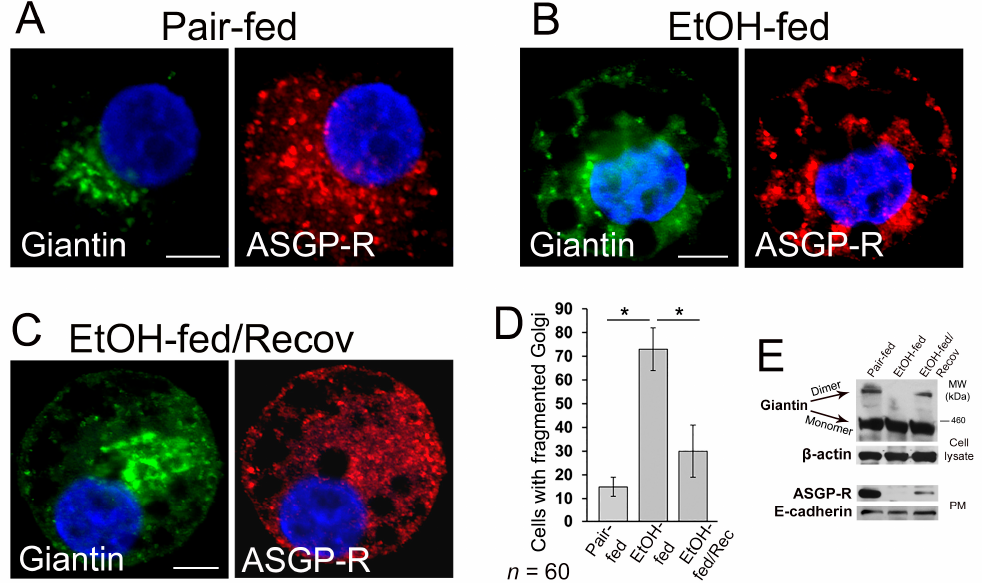
Figure 2. Post-alcohol Golgi biogenesis in vivo. ( A – C ) Giantin and asialoglycoprotein receptor (ASGP-R) immunostaining in hepatocytes obtained from rats: pair-fed ( A ), ethanol (EtOH)-fed ( B ), and EtOH-fed followed by the recovery; bars, 5 µ m ( C ); ( D ) Quantification of cells with fragmented Golgi in cells from ( A – C ); n = 60 cells from two independent experiments, results are expressed as a mean ± SD; * p < 0.001; ( E ) Top panel: giantin W-B of lysates from cells described in ( A – C ); β -actin is a loading control. Low panel: ASGP-R W-B of plasma membrane fractions from cells described in ( A – C ); samples were normalized to E-cadherin.